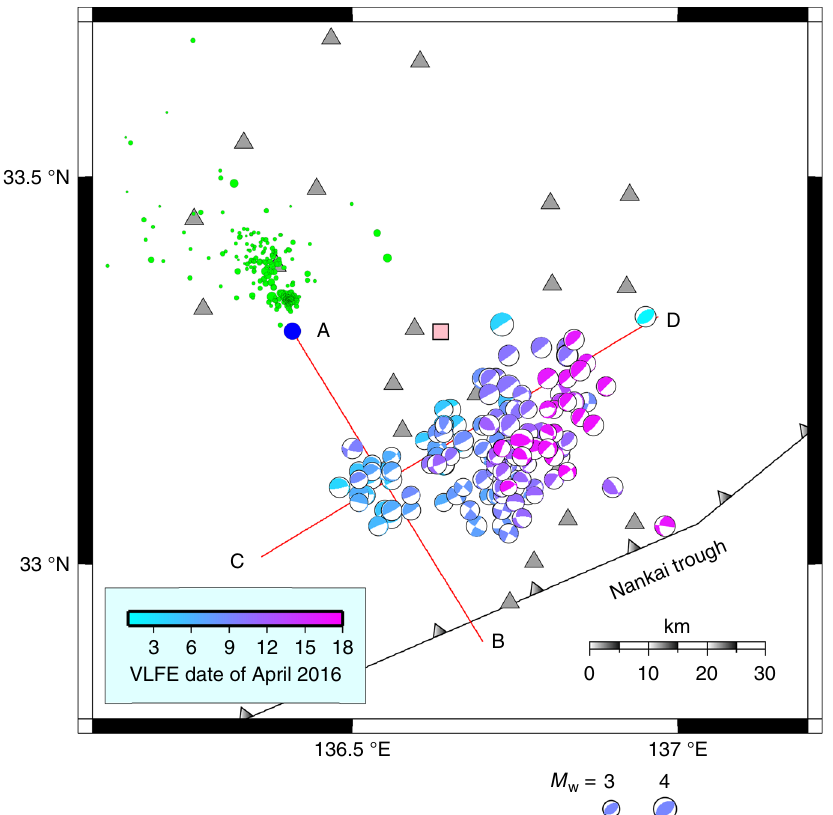
Fig. 3 Spatiotemporal distribution of sVLFEs in 2016. Focal mechanism symbols represent sVLFE locations; each symbol is colored according to the occurrence date, and the symbol size is proportional to moment magnitude ( M w ). Blue circle represents the mainshock of the 1 April 2016 off-Mie earthquake; green circles represent aftershocks. Gray triangles indicate DONET stations; pink square is borehole station C0002G. Lines A – B and C – D mark cross sections shown in Fig. 5. Location shown in Fig.